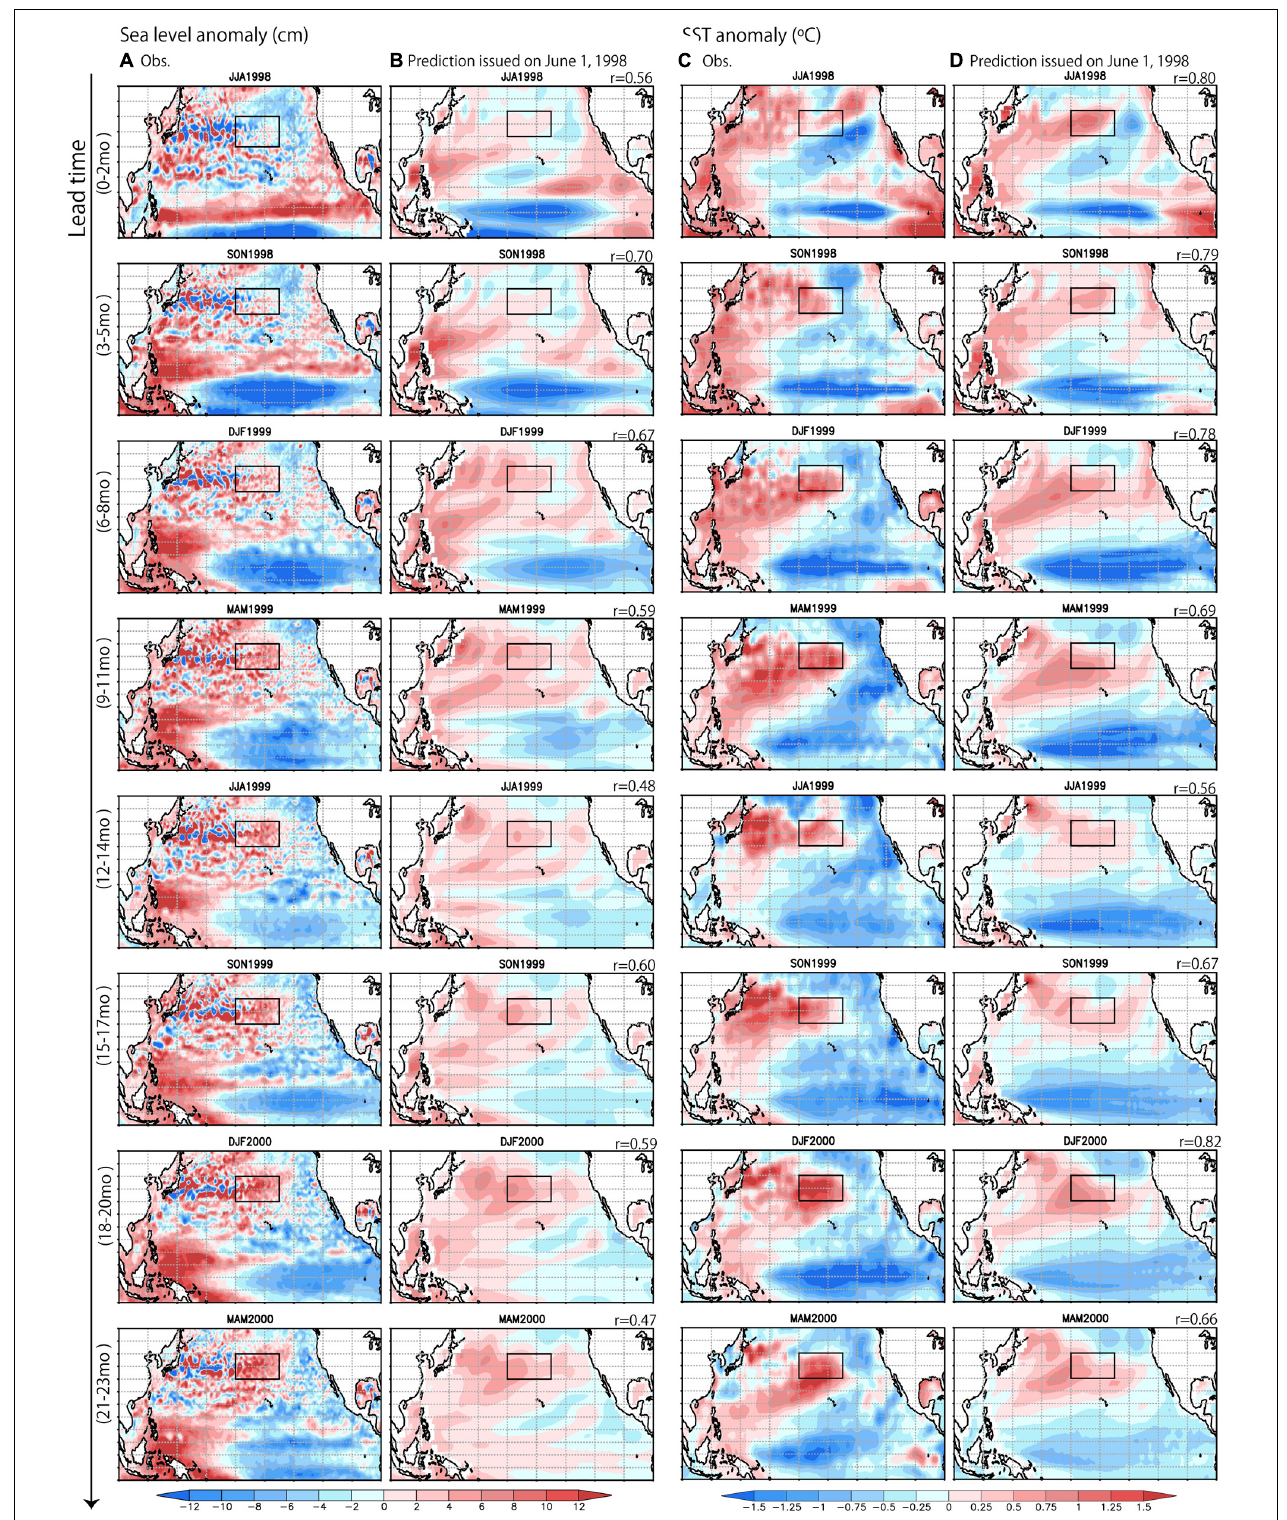
FIGURE 4 | (A) Three-month averaged variations of sea level anomaly (cm) from June–August 1998 (upper) through March–May 2000 (bottom). The box shows the study region of 30 ◦ –40 ◦ N, 180 ◦ –150 ◦ W based on observation. (B) Same as (A) , but for prediction issued on June 1, 1998 (ensemble mean). Pattern correlation is shown in the upper right corner. (C,D) Same as (A,B) , but for SST ( ◦ C).